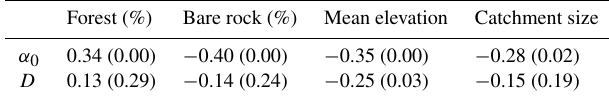
Table 4. Spearman correlations between model parameters and catchment characteristics indicating alpine and lowland areas where the spatial distribution of SWE is expected to vary. The bracketed numbers indicate significance ( p